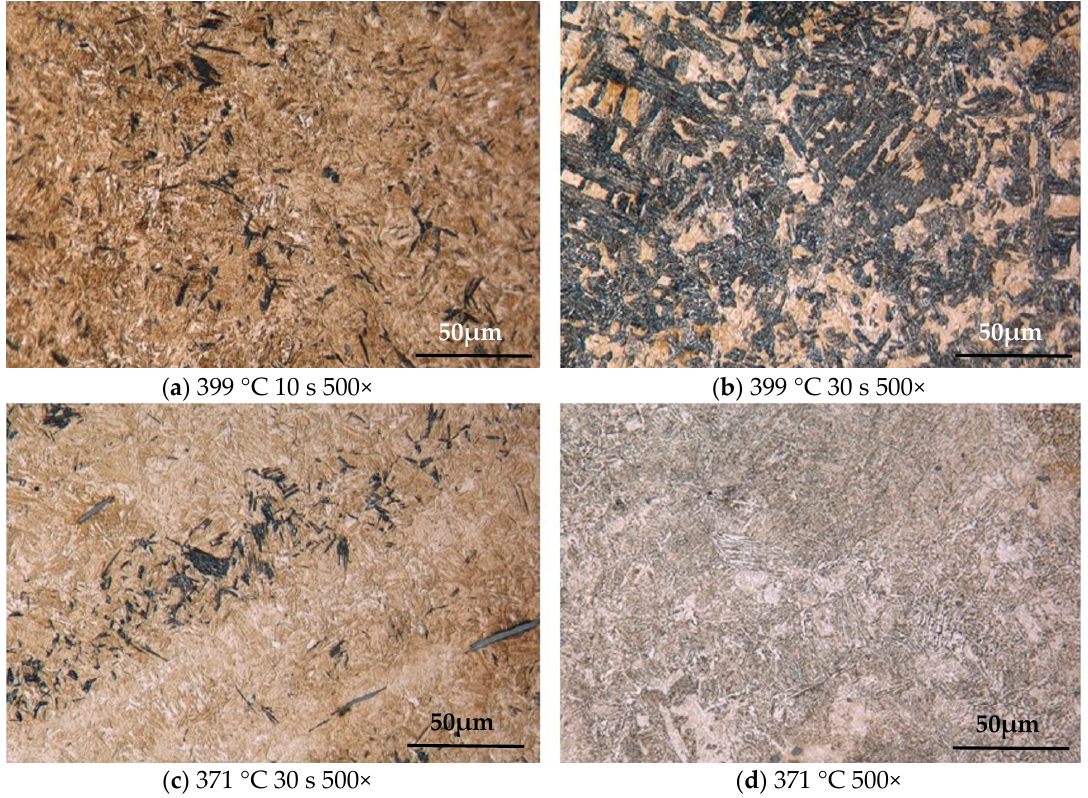
Figure 5. ( a – d ) Microstructure of 4140 steel as a result of isothermal temperature at 399 °C and 371 °C.